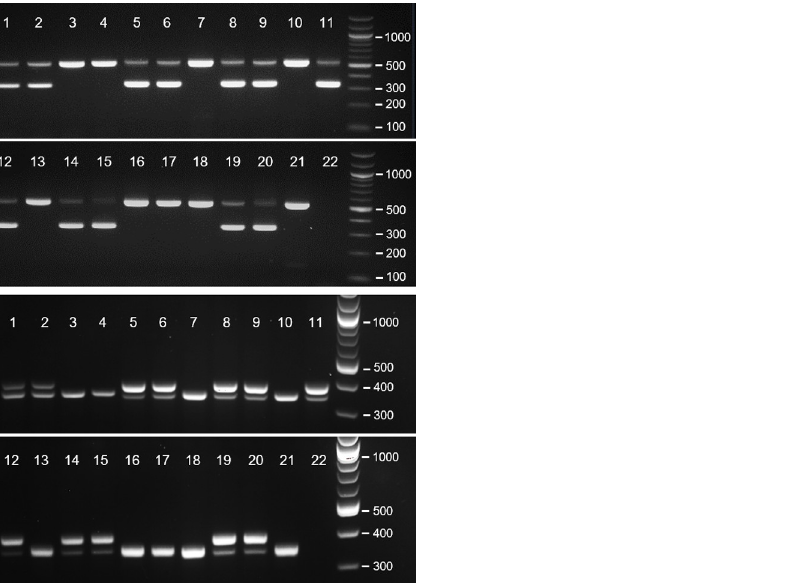
Fig 1. Gel electrophoresis of PCR products amplified using DNA extracted from embryonic tissues. (A) Results using the mCHD1F/mCHD1R primer pair. (B) Results using the mP2/P8 primer pair. Lane numbers correspond to the samples listed in Table 2.